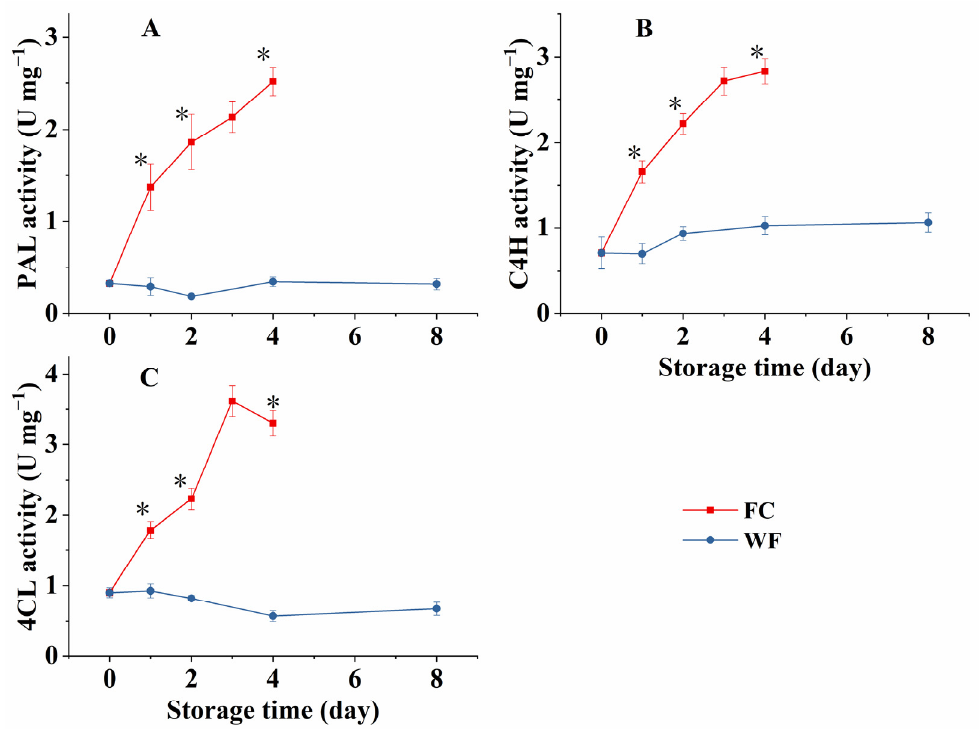
Figure 3. Effect of cutting on the activities of ( A ) phenylalanine ammonia-lyase (PAL), ( B ) cinnamate 4-hydroxylase (C4H), and ( C ) 4-coumarate: CoA ligase (4CL) in melon fruit during storage (15 °C). FC and WF respectively represent fresh-cut and whole melon fruit. The values are expressed as means ± SE of three replicates. * indicate statistically significant differences ( p < 0.05) according to Student’s t -test at each sampling point.